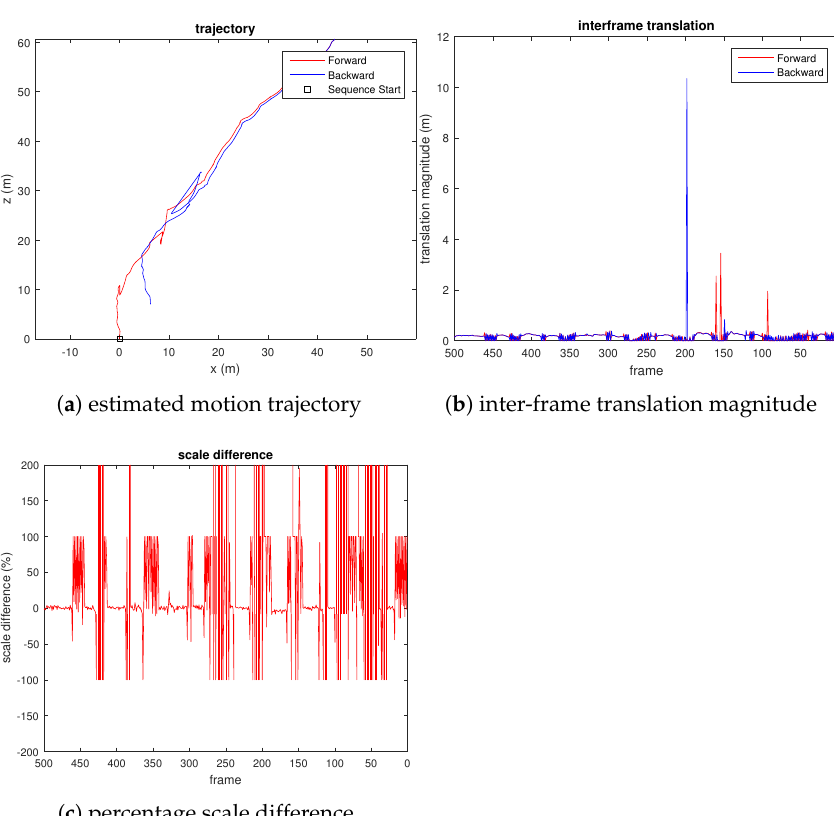
Figure 7. Plots evaluating the scale drift of VISO2-M [22] visual odometry on UAV video, where percentage scale difference refers to the percentage error of the translation magnitude compared to the true translational